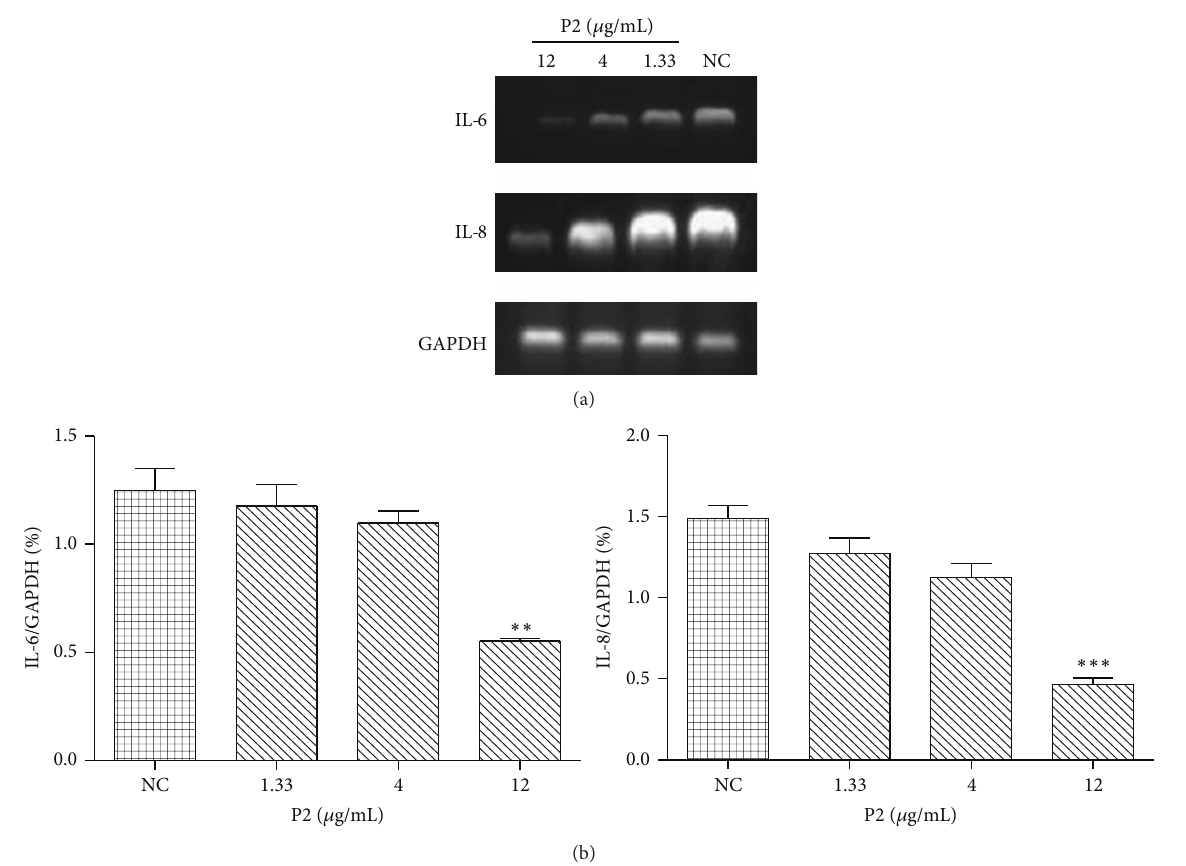
Figure 3: (a) Effect of P2 on immune-related gene expression in HeLa cells. mRNA expression of proinflammatory cytokines in HeLa cells treated with P2 as described in Section 2.6 was analyzed by RT-PCR. GAPDH was used as an internal control. Results are representative of three independent experiments. (b) Quantification of transcript levels by RT-PCR. The primer pair for GAPDH was used as the reference gene. ∗∗ 𝑃 < 0.01 and ∗∗∗ 𝑃 < 0.001 compared with NC. The results are representative of three independent experiments and expressed as mean ± SD. Differences were defined as significant at 𝑃 < 0.05